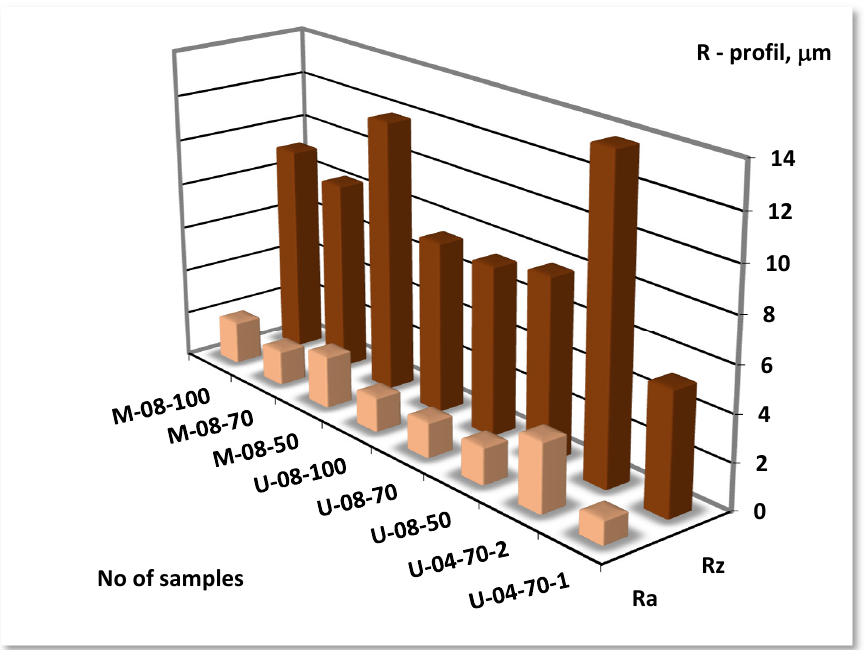
Figure 2. Rz —maximum height of profile; Ra —arithmetical mean deviation of the roughness profile for samples DSS after turning.